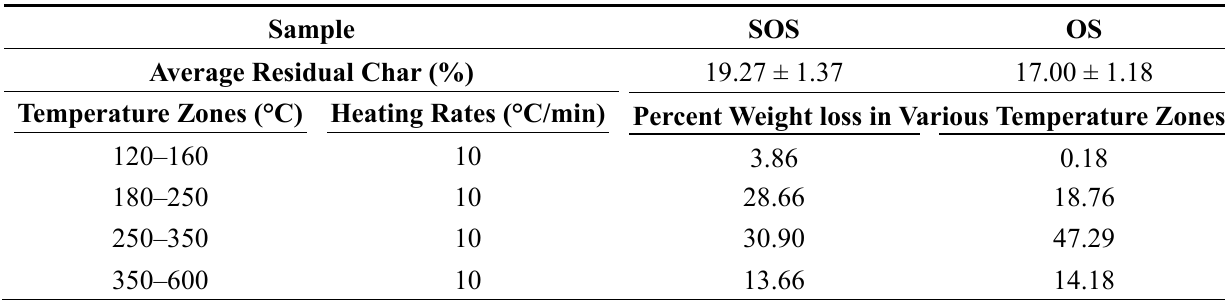
Table 3. Average residual char yield and weight loss observed in various temperature zones during TGA analysis of freeze-dried osmotic solution (OS) and SOS samples generated from blueberry